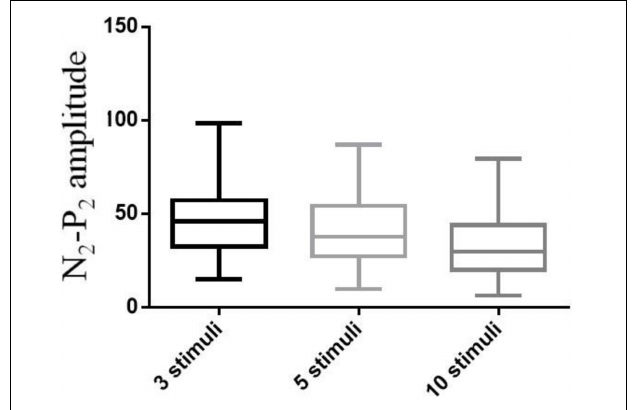
FIGURE 2 | N2–P2 amplitudes at the right forearm with 3, 5, and 10 stimuli.